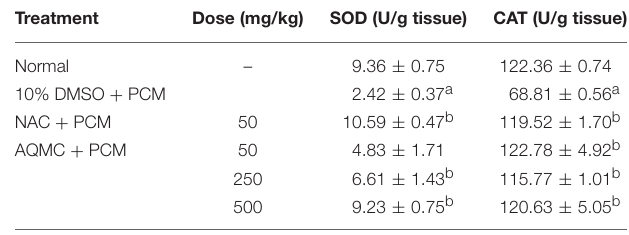
TABLE 8 | Effect of AQMC, at 50, 250, and 500 mg/kg, on the activities of endogenous antioxidant enzymes, namely SOD and CAT, of PCM- intoxicated rats.